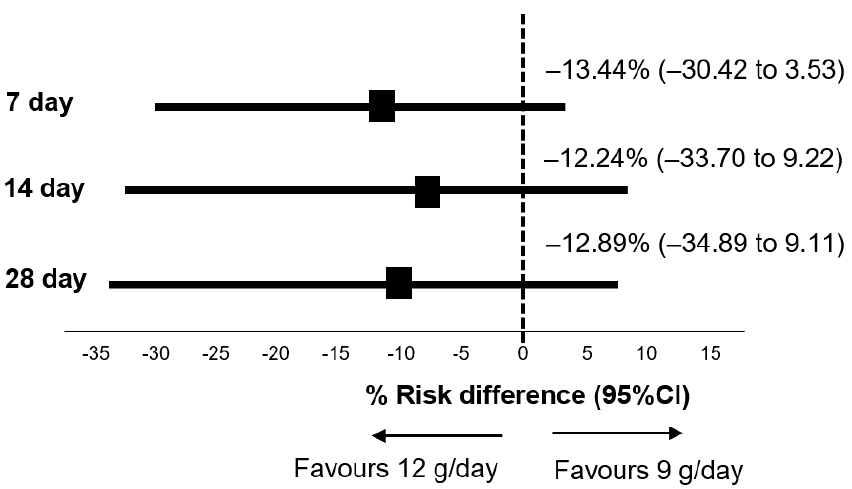
Figure 4. Risk difference for mortality at day 7, 14, 28 in patients treated with 12 g/day vs. 9 g/day of sulbactam. Abbreviation: CI, confidence